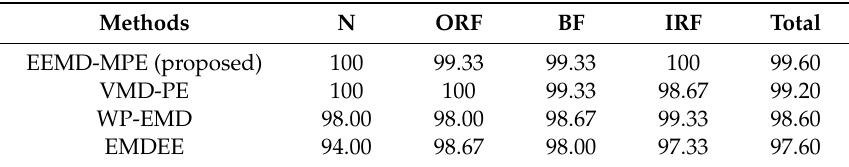
Table 5. Classification accuracy (%) using di ff erent feature extraction